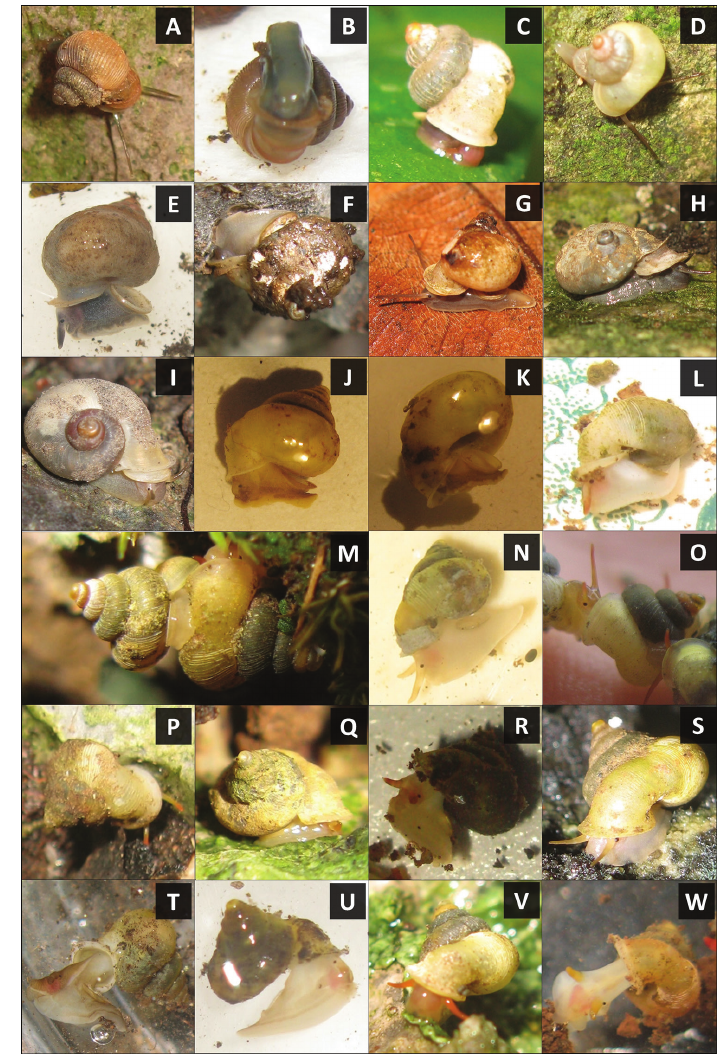
Figure 7. Photographs of 18 living Alycaeus species. A–B Alycaeus balingensis Tomlin, 1948, BOR/MOL 8356 C Alycaeus liratulus (Preston, 1907), BOR/MOL 8334 D Alycaeus thieroti Morgan, 1885b, BOR/ MOL 6835 E Alycaeus conformis Fulton, 1902, BOR/MOL 6809 F Alycaeus gibbosulus Stoliczka, 1872, BOR/MOL 6850 G Alycaeus gibbosulus Stoliczka, 1872, BOR/MOL 8526 H Alycaeus jousseaumei Mor- gan, 1885a, BOR/MOL 8341 I Alycaeus jousseaumei Morgan, 1885a, BOR/MOL 8336 J Alycaeus alticola sp. n., BOR/MOL 8398 K Alycaeus charasensis sp. n., BOR/MOL 8399 L Alycaeus clementsi sp. n., BOR/ MOL 8364 M Alycaeus costacrassa sp. n., BOR/MOL 6811 N Alycaeus expansus sp. n., BOR/MOL 6367 O Alycaeus kapayanensis Morgan, 1885b, BOR/MOL 13005 P Alycaeus kelantanensis Sykes, 1902, BOR/ MOL 8325 Q Alycaeus kelantanensis Sykes, 1902, BOR/MOL 6200 R Alycaeus kurauensis sp. n., BOR/ MOL 6851 S Alycaeus perakensis Crosse, 1879a, BOR/MOL 6852 T Alycaeus regalis sp. n., BOR/MOL 6881 U Alycaeus selangoriensis sp. n., BOR/MOL 6371 V–W Alycaeus senyumensis sp. n., BOR/MOL 6249. All photographs by Junn Kitt